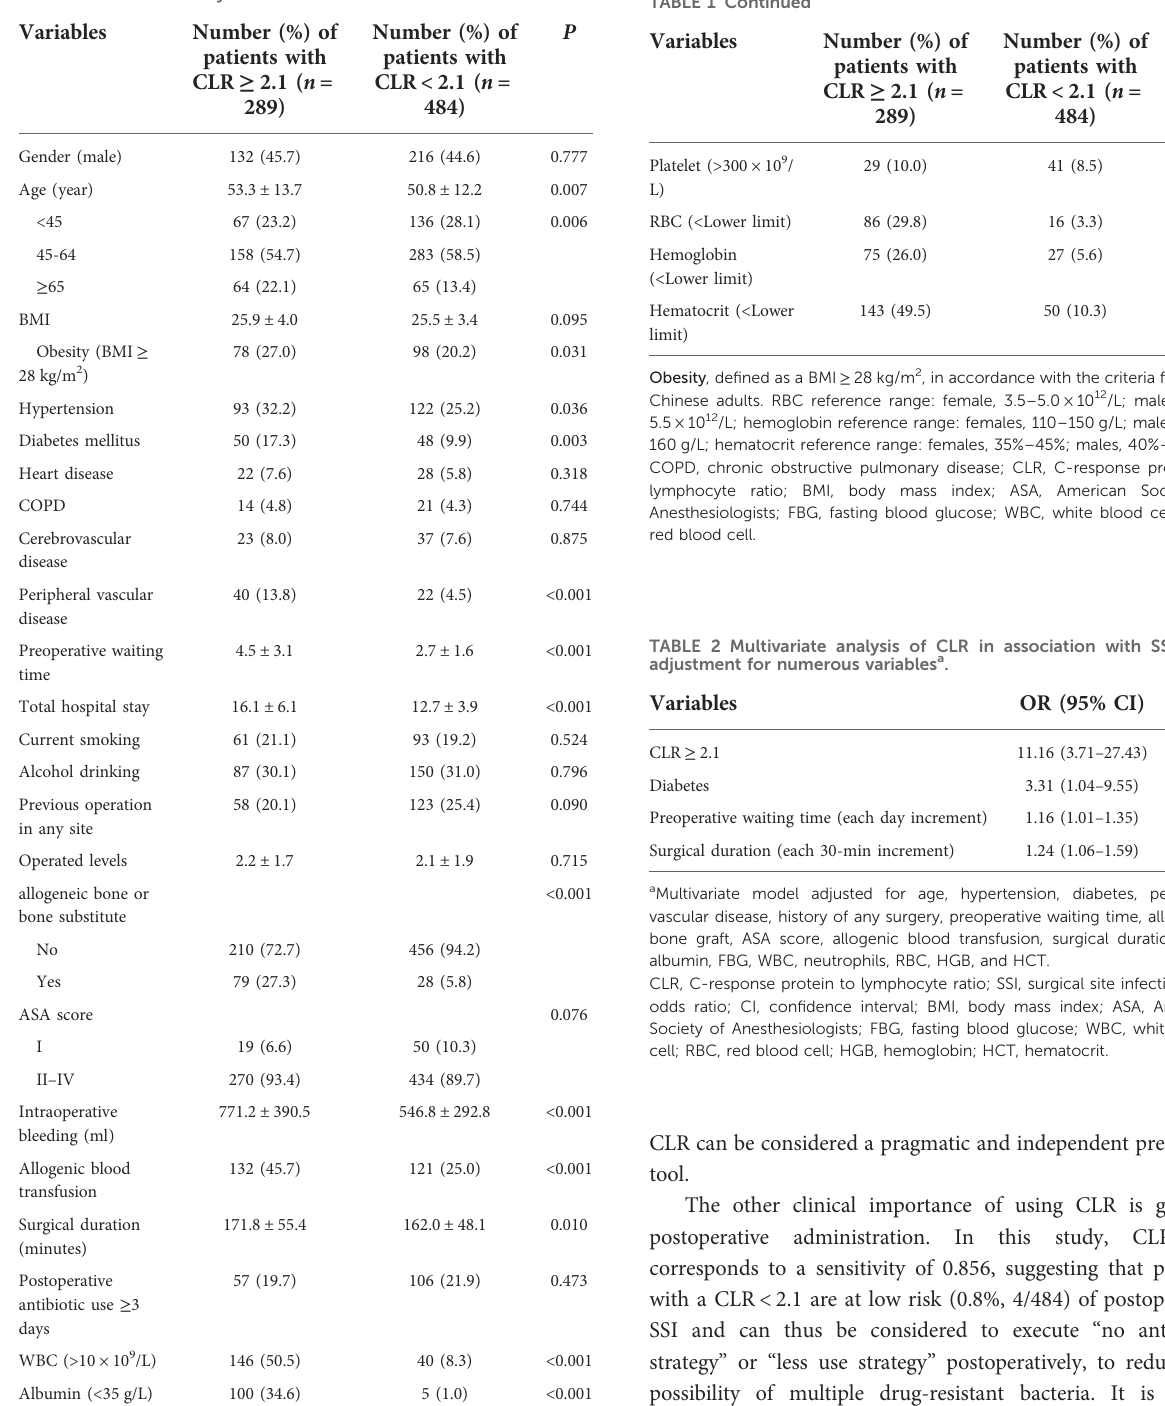
TABLE 1 Univariate analysis of factors associated with CLR.